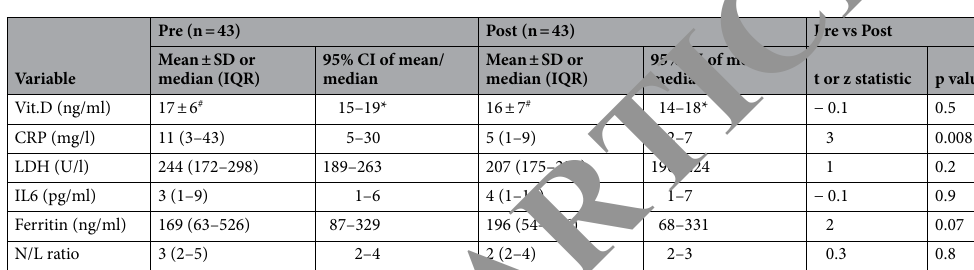
Table 2. Values of various parameters studied in the NVD group before and after treatment. Vit.D Vitamin D, CRP C-reactive protein, LDH Lactate dehydrogenase, Il-6 Interleukin-6, N/L ratio Neutrophil/Lymphocyte ratio, IQR Interquartile range, # mean ± SD, * 95% CI of mean.